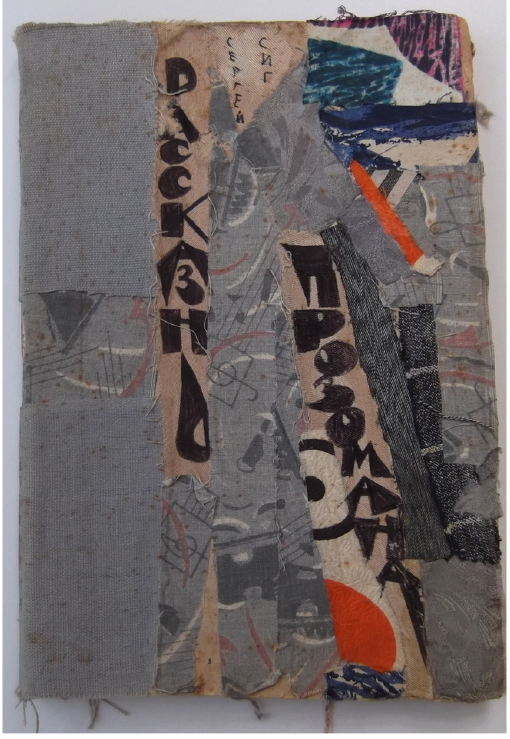
Figure 21. Cover of Sigei’s ‘Raskazn’.